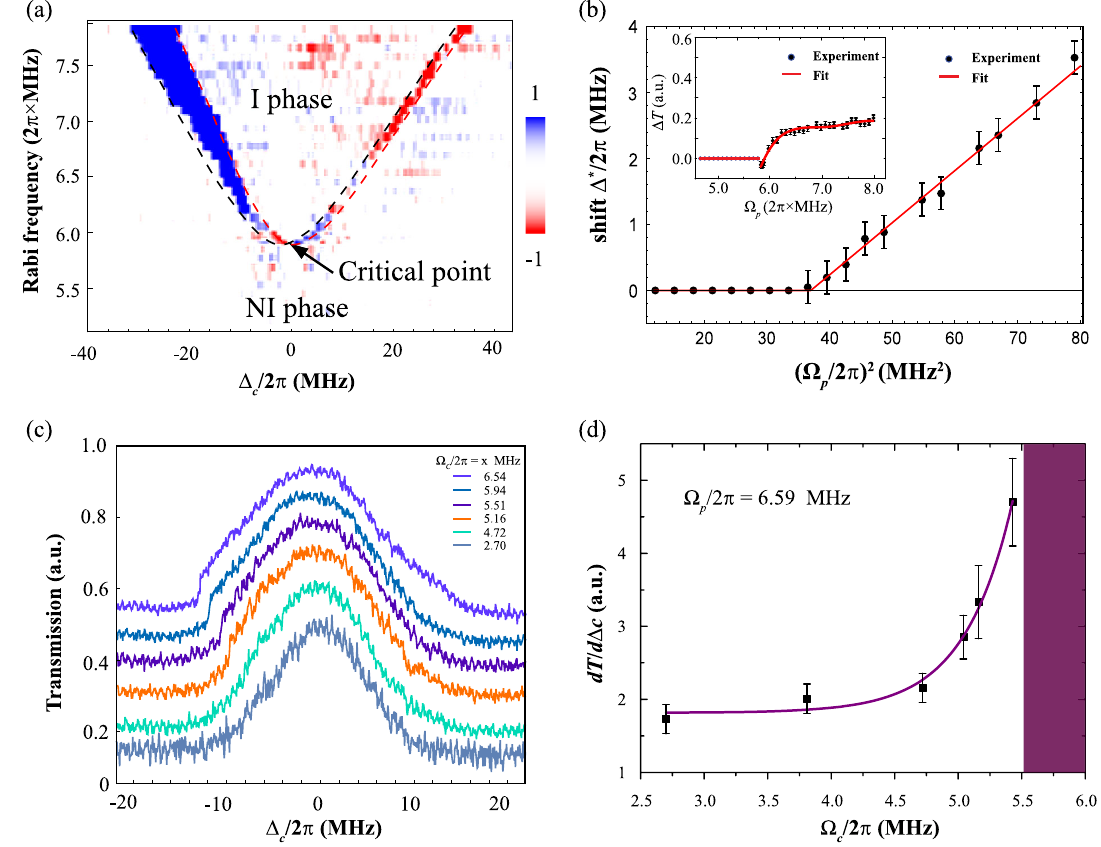
FIG. 4. Characterizing the nonequilibrium phase transition. (a) Color map of the difference in probe transmission (normalized to the respective maximal values) when scanning Δ in either direction, effectively representing the phase diagram of the nonequilibrium c system. In the white regions, the system is found in the same phase independent of the scan direction. In the shaded regions, the system is bistable (red if transmission is higher for scans from negative to positive Δ , blue in the opposite case) and occupies different phases p ∝ ρ . Inset: Transmission difference at the transition point for depending on the scan direction. (b) Shift of peak transmission Δ (cid:3) vs Ω 2 p rr = 2 π between 2.7 and 6.54 MHz; here, different Ω [see Fig. 3(a5) for definitions]. (c) Measurement of transmission spectra vs Δ for Ω p c c Ω = 2 π ¼ 6 . 59 MHz. (d) Susceptibility of the phase transition to variations in Ω measured in terms of the change in transmission p c d T= d Δ . The shaded region indicates where the system is in the I phase, and d T= d Δ is no longer continuous at the transition point. The c c 1 . 97 × 10 6 e ð Ω c = ξ Þ þ 1 . 82 ; ξ ¼ 2 π × 0 . 38 MHz is the fitted critical fit is given by d T= d Δ c ¼